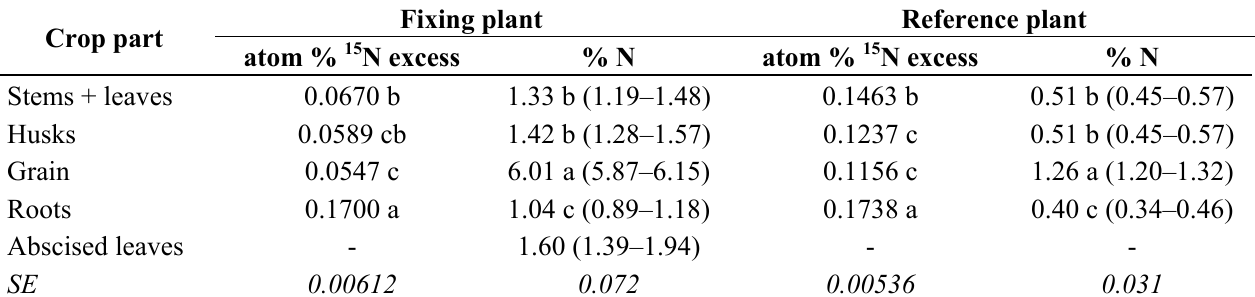
Table 3. Isotope 15 N excess and total N concentration in different fixing and non-fixing plant parts in Nyabeda, western Kenya, March–August 2007 cropping